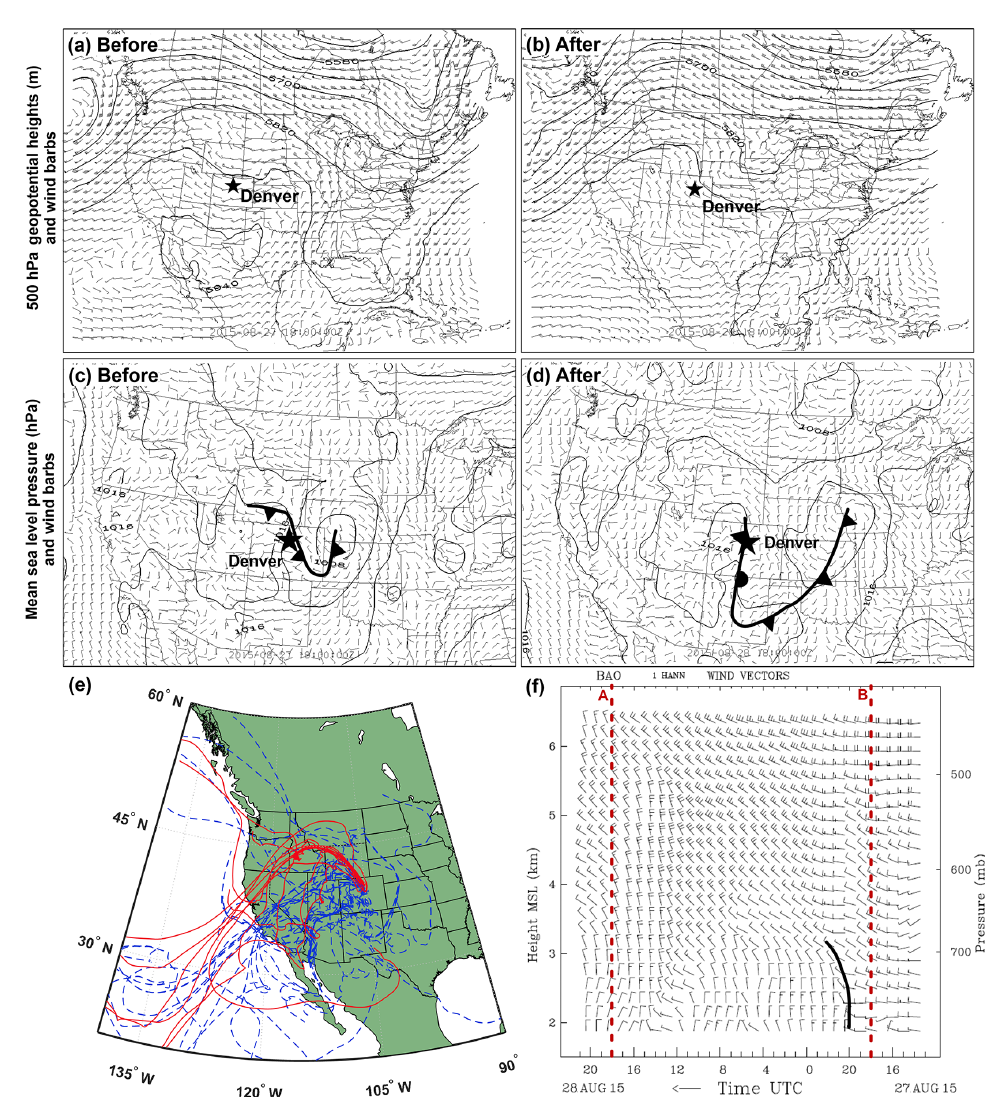
Figure 9. Same as Fig. 7 but for event 3 (29 August 2015). Before and after the cold-frontal passage correspond to 18:00UTC on 27 August and 18:00UTC on 28 August, respectively. Trajectories were initiated for the time period surrounding event 3 (26–29 August). Time–height section measurements were between 13:00UTC on 27 August and 21:00UTC on 28